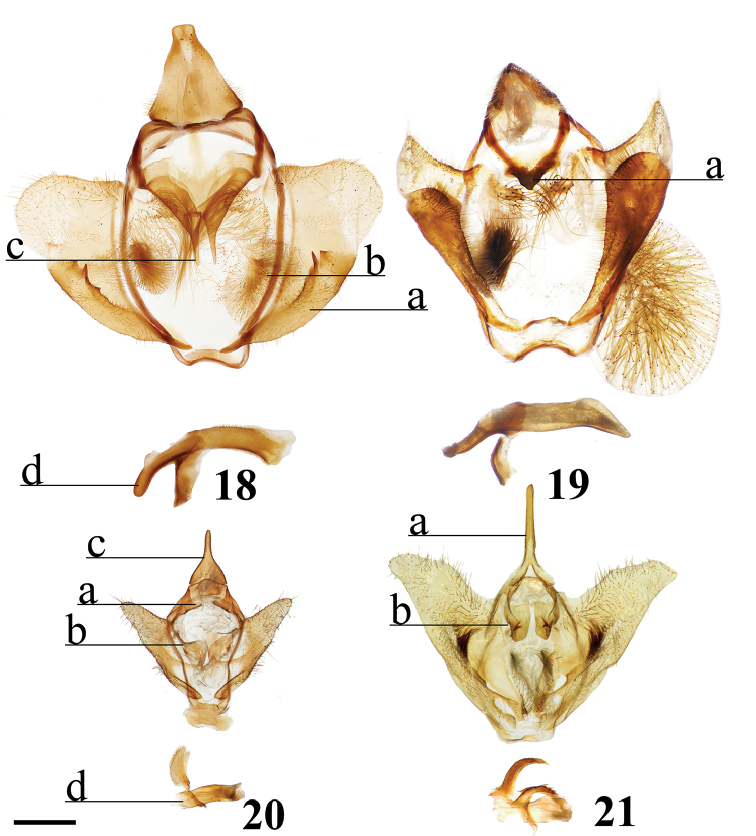
Ventral view of male genitalia of type species of genera belonging to Lacosominae: Trogopterini and Lacosomini. Phallus/juxtal complex is figured below the genitalia in the lateral view. 18Reinmaraenthona, St Laurent diss.: 5-18-16:1 (CNC) 19Trogopteracfnotata, St Laurent diss.: 17-3-18:5 (MGCL) 20Lacosomachiridota, St Laurent diss.: 10-5-17:5 [reused with permission from St Laurent et al. (2018a), Systematic Entomology] (CRAS) 21Vanengamera, St Laurent diss.: 7-7-16:2 [reused with permission from St Laurent and Herbin (2017), ZooKeys] (NHMUK). Scale bar: 1 mm.